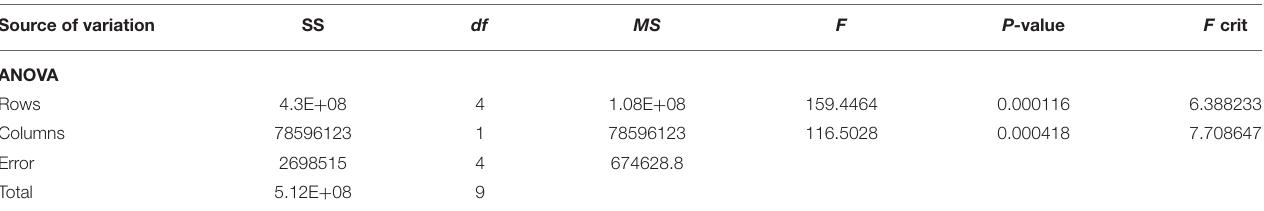
TABLE 13 | Statistical analysis of Rabi season from Table 14